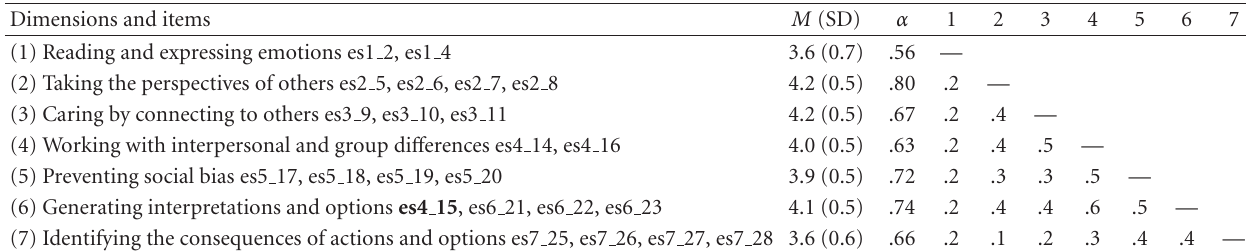
Table 2: Means, alpha loadings, and correlations of the dimensions of the ESSQ. Dimensions and items